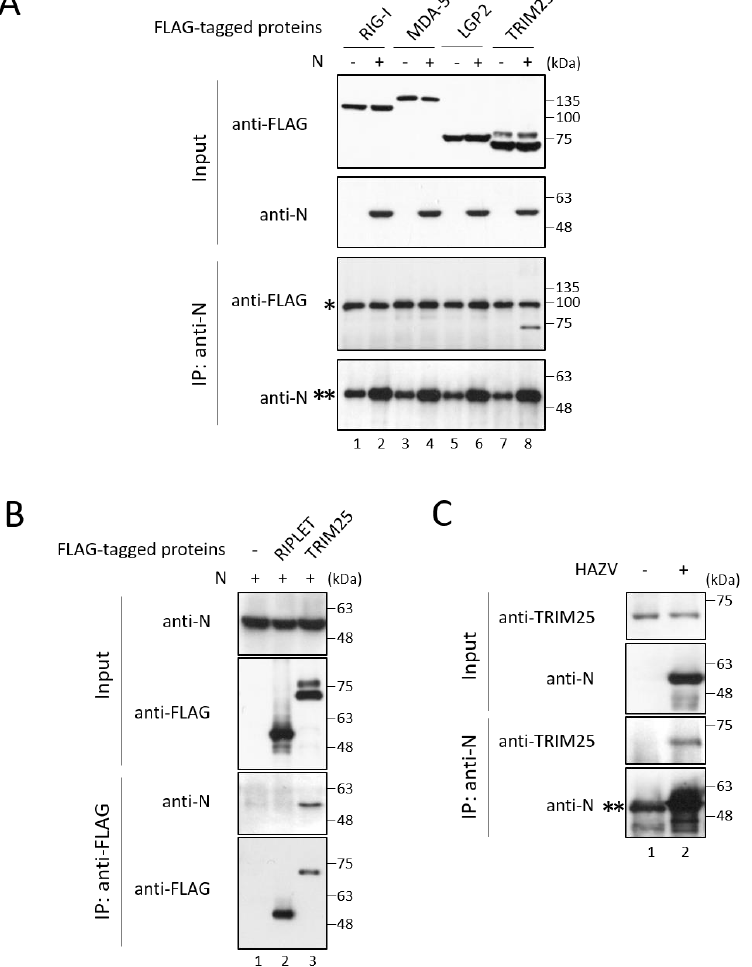
Figure 2. Interaction between N protein and IFN-related proteins. ( A , B ) COS cells were transfected with the indicated plasmids. After 48 h, cell lysates were directly analyzed by immunoblot (input). The cell lysates were immunoprecipitated with the indicated Ab, followed by immunoblot. A single asterisk indicates unknown non-specific bands. Double asterisks indicate an immunoglobulin heavy chain. ( C ) HeLa cells were either mock-infected or infected with HAZV at an MOI of 1.0. After 48 h, cell lysates were subjected to immunoblot and immunoprecipitation as described in ( A ). All experiments were performed at least three times independently.